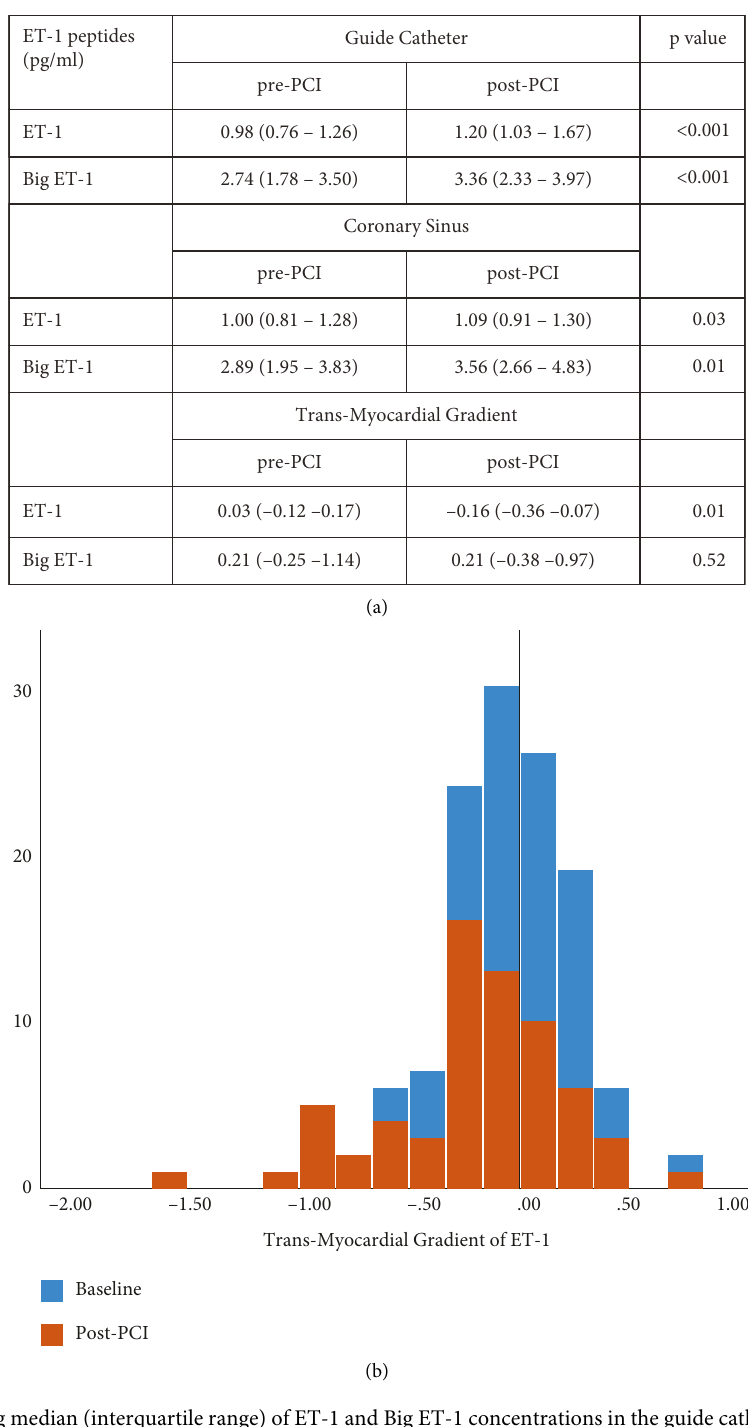
Figure 1: (a) Table showing median (interquartile range) of ET-1 and Big ET-1 concentrations in the guide catheter (stationed in the aortic root) and coronary sinus pre- and post-PCI. Levels of ET-1 and Big ET-1 increase significantly at both sites following PCI. (b) Histogram showing changes in the trans-myocardial gradient (coronary sinus minus guide catheter levels) of ET-1 pre-and post-PCI: trans-myocardial gradients are neutral at baseline with increased extraction (leftward shift)